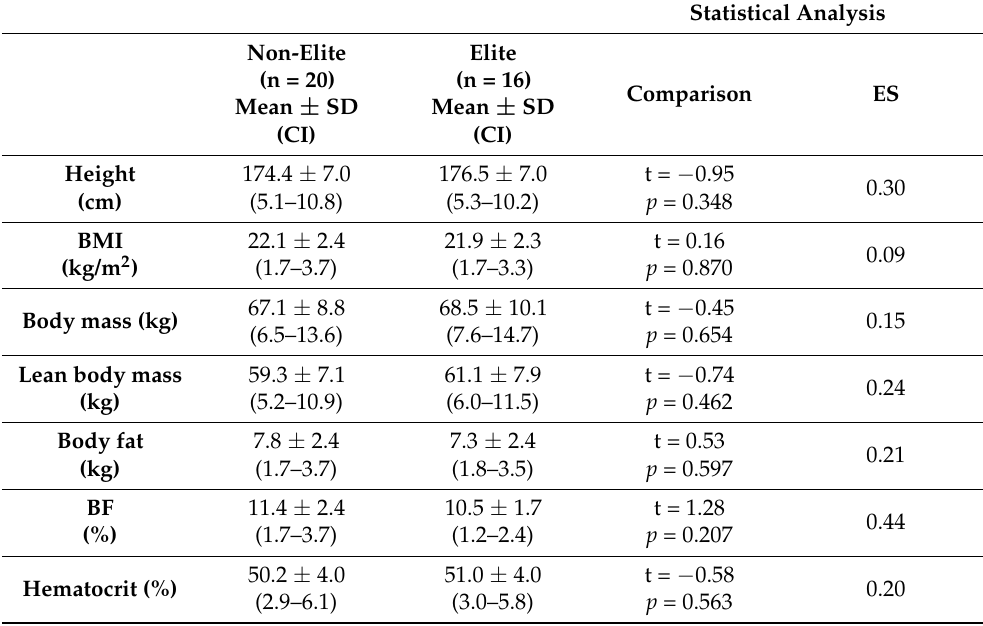
Table 1. Characterization of anthropometric and body composition variables of both